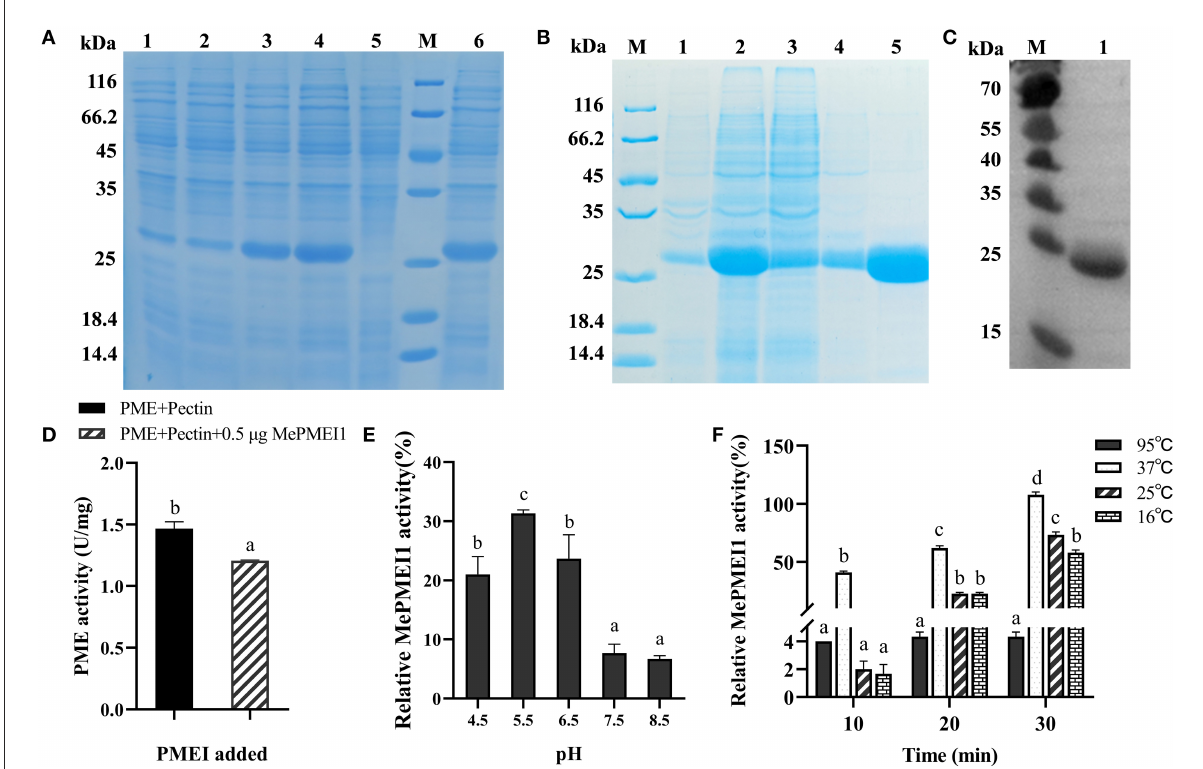
FIGURE4 Determination of the expression and biological functions of MePMEI1. (A) Expression of the crude MePMEI1 recombinant protein under different conditions of induction; lane 1: 15 ◦ C, 0.2mM IPTG; lane 2: 15 ◦ C, 1mM IPTG; lane 3: 37 ◦ C, 0.2mM IPTG; lane 4: 37 ◦ C, 1mM IPTG; lane 5: non-induced cells; and lane 6: insoluble protein fraction after induction with 1mM IPTG at 37 ◦ C. (B) Expression of purified recombinant MePMEI1 protein in the sediment and supernatant following the disruption of inclusion bodies (lanes 1 and 2), protein effluent (lane 3), and flushed out a sample (lane 4). Lane 5 depicts the expression of the purified recombinant MePMEI1 protein. (C) Western blotting for the detection of the recombinant MePMEI1 protein; lane 1: recombinant MePMEI1 protein; M: molecular marker (kDa). (D) Assay for determining PME activity following the addition of the recombinant MePMEI1 protein. Effects of different (E) pH and (F) temperature on the activity of MePMEI1. The data are presented as the mean ± SEM of observations from triplicate assays. The different letters indicate significant differences at the 0.05 level (Duncan